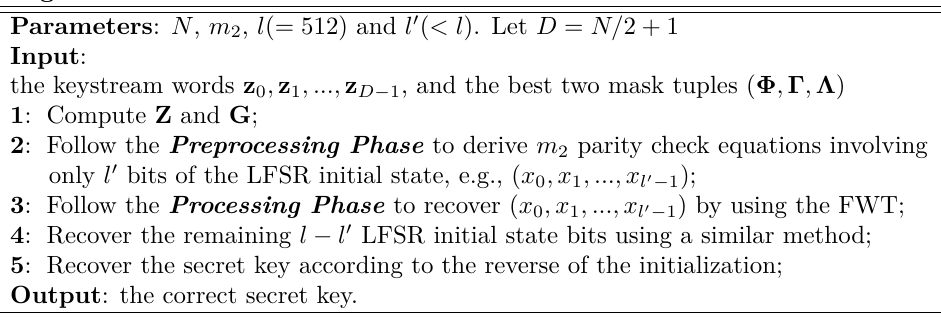
Algorithm 4 the bitwise fast correlation attack on SNOW